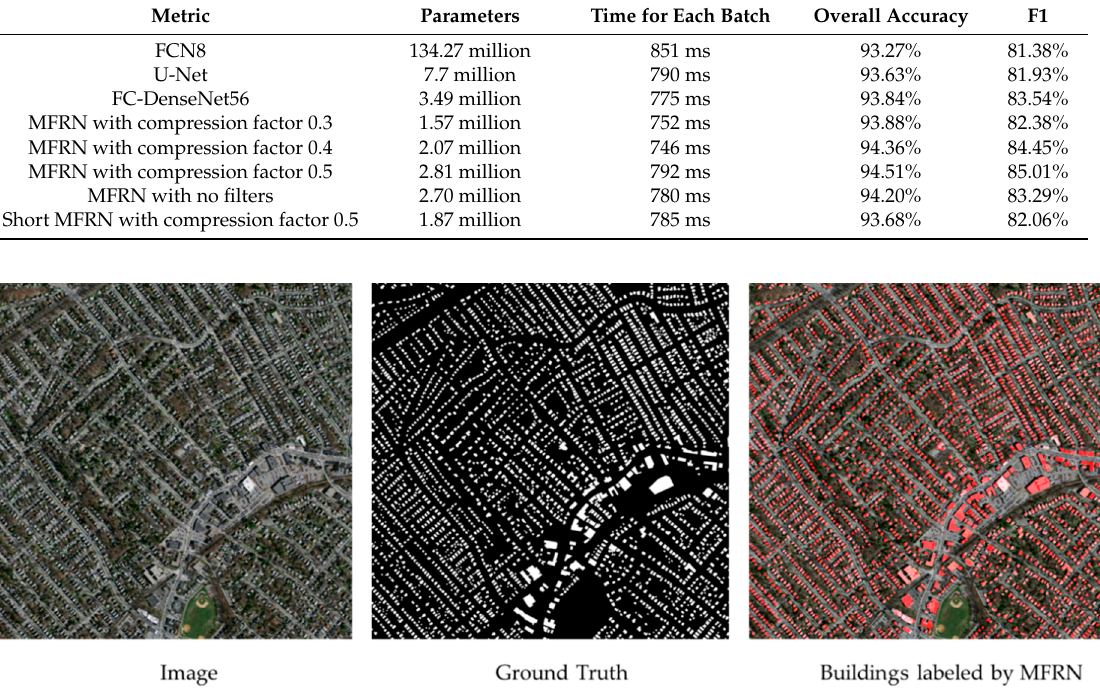
Figure 8. An illustration of a 3 × 3 image, the corresponding building labels and the final processed image with buildings labeled by the MFRN.